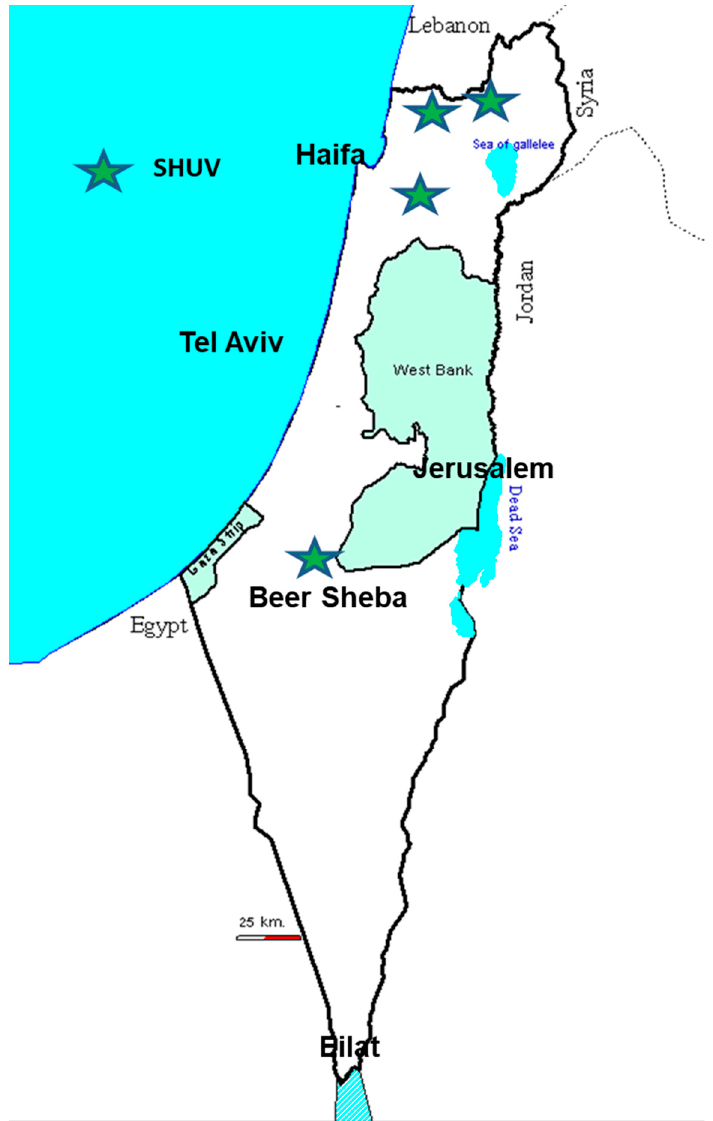
Figure 5. This figure shows the infected sites of arthrogryposis hydranencephaly syndrome associated with Shuni-virus (SHUV) in 2014/15 and 2018/19.